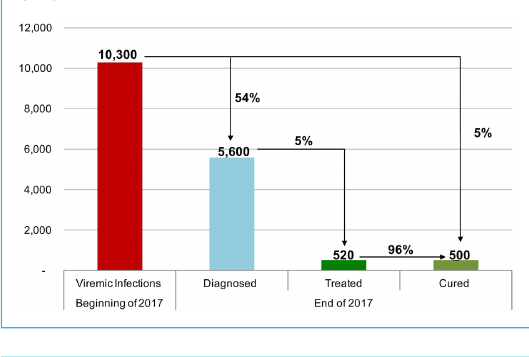
Figure 12: Distribution of viremic infections by disease stage in the canton of Zurich from 1950–2030 under the Base 2016 sce-